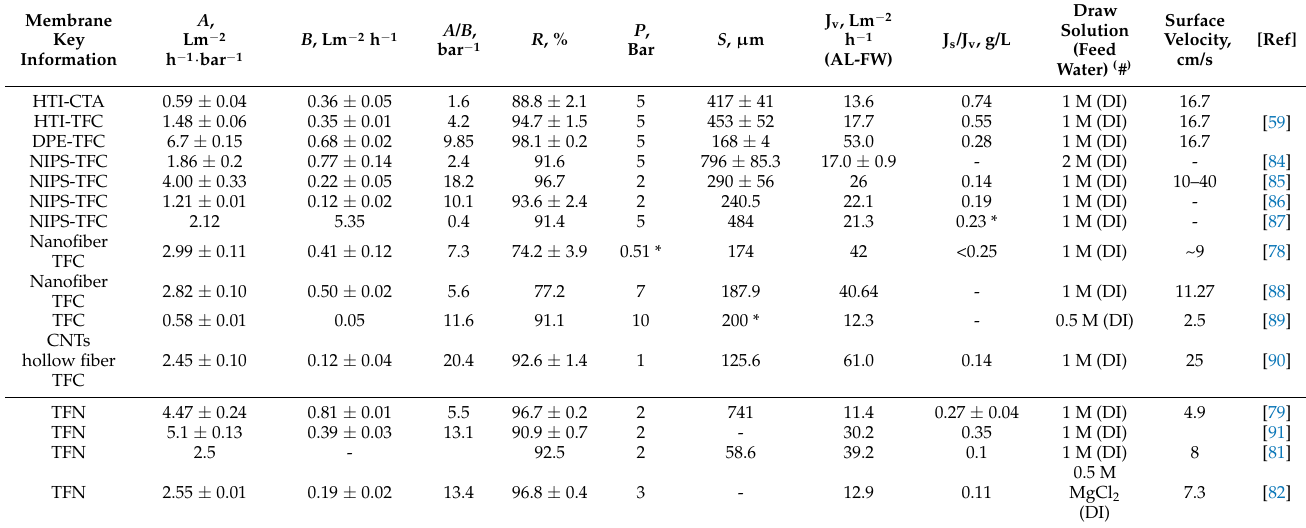
Table 2. Basic information of the typical reported FO membranes and testing